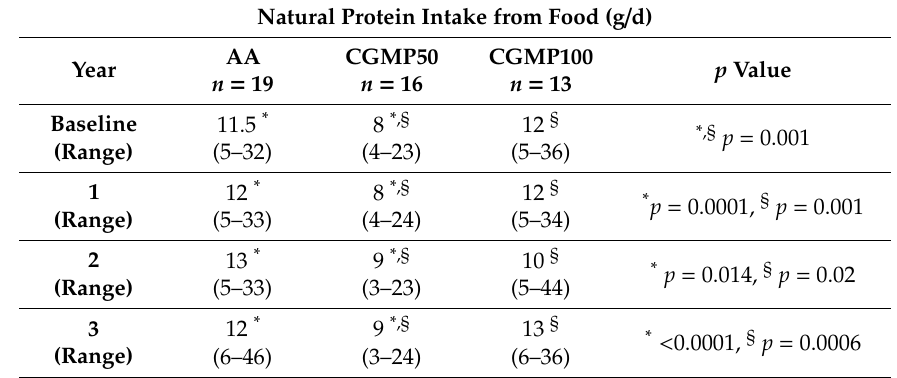
Table 4. Median natural protein intake (g / day) (range) from food sources only and median percentage intake from protein equivalent from substitute from baseline to year 3 in AA, CGMP50 and CGMP100. Natural Protein Intake from Food (g /